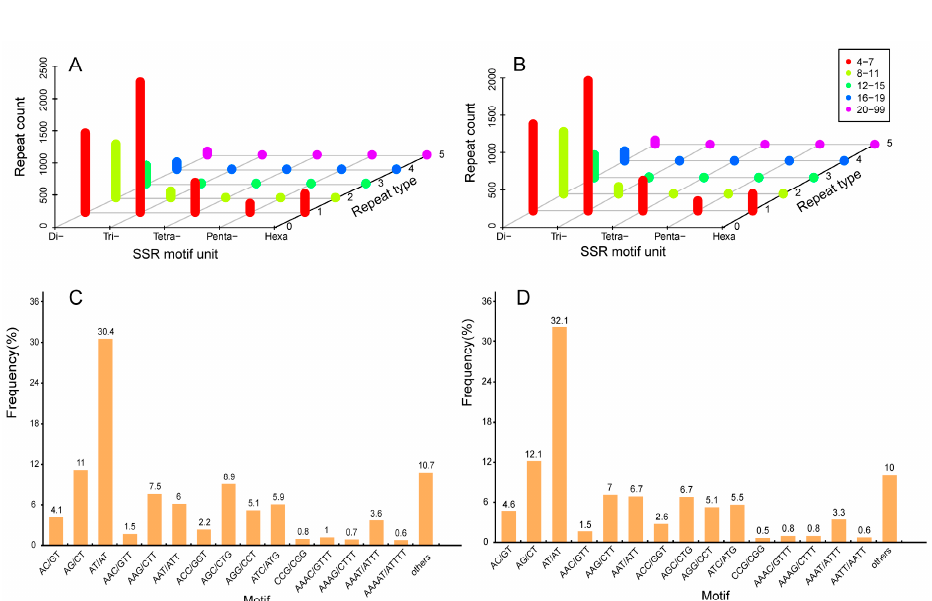
Figure 7. Comparison of different simple sequence repeat (SSR) among FER and STE. The distribution of SSRs based on the number of repeat units in FER ( A ) and STE ( B ); frequency distribution of SSRs based on motif types in FER ( C ) and STE ( D ). Table 1. Summary of SSRs identified in P. tabuliformis transcriptome of FER and STE ovule.